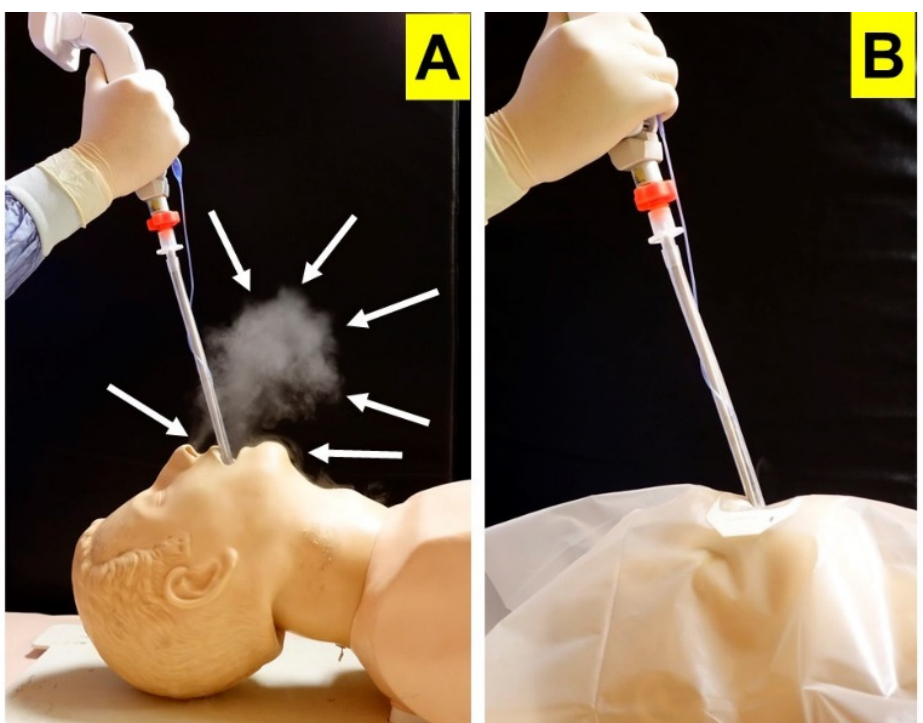
Figure 10. Mannequin demonstration of how the plastic sheet barrier prevents spread of respiratory droplets and aerosols during endotracheal intubation. ( A ) Endotracheal intubation using video intubating stylet without plastic sheet showing visible secretions (arrows) after a simulated cough. ( B ) When a plastic sheet barrier is used, secretions are contained under the sheet after a simulated cough. (Courtesy photos reproduced from Cell Transplantation [39]).